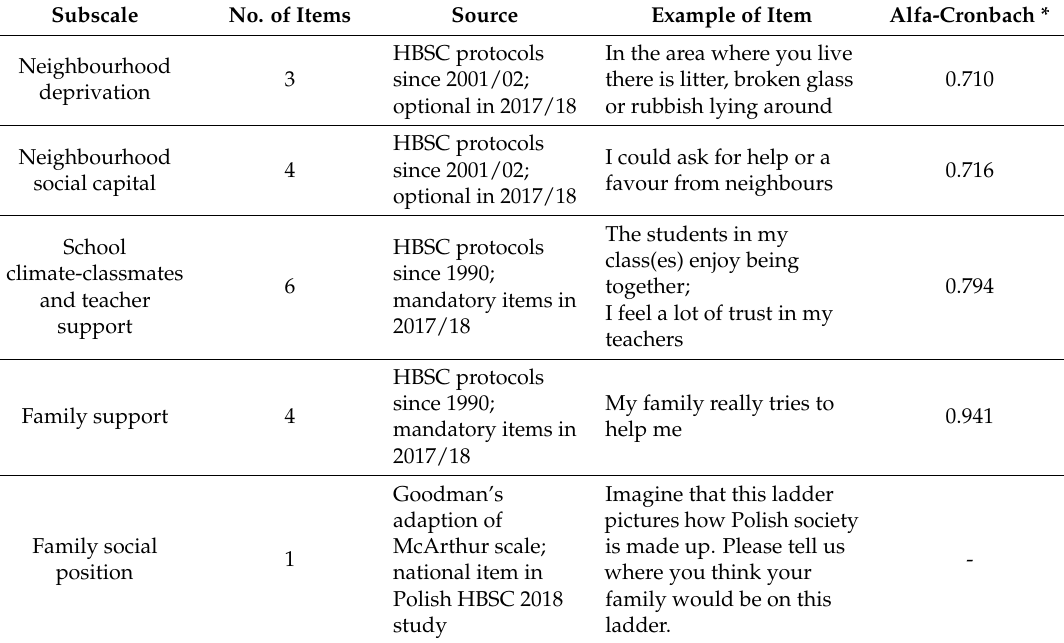
Table 1. The components of the scale describing the growing up